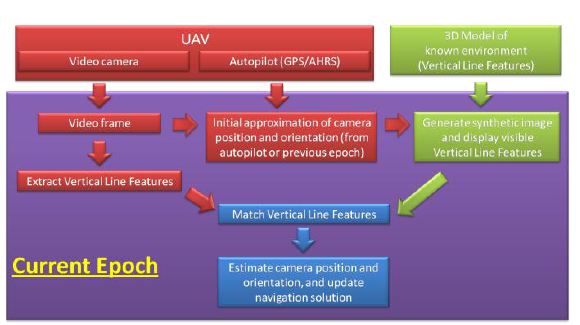
Figure 1. The self-localization process The main contribution of this paper lies in automating the localization process because an FPV video sequence typically consists of thousands of frames. It is based on a simple, efficient, and robust feature extraction approach developed to find correspondence between video frames and the 3D model of the environment.